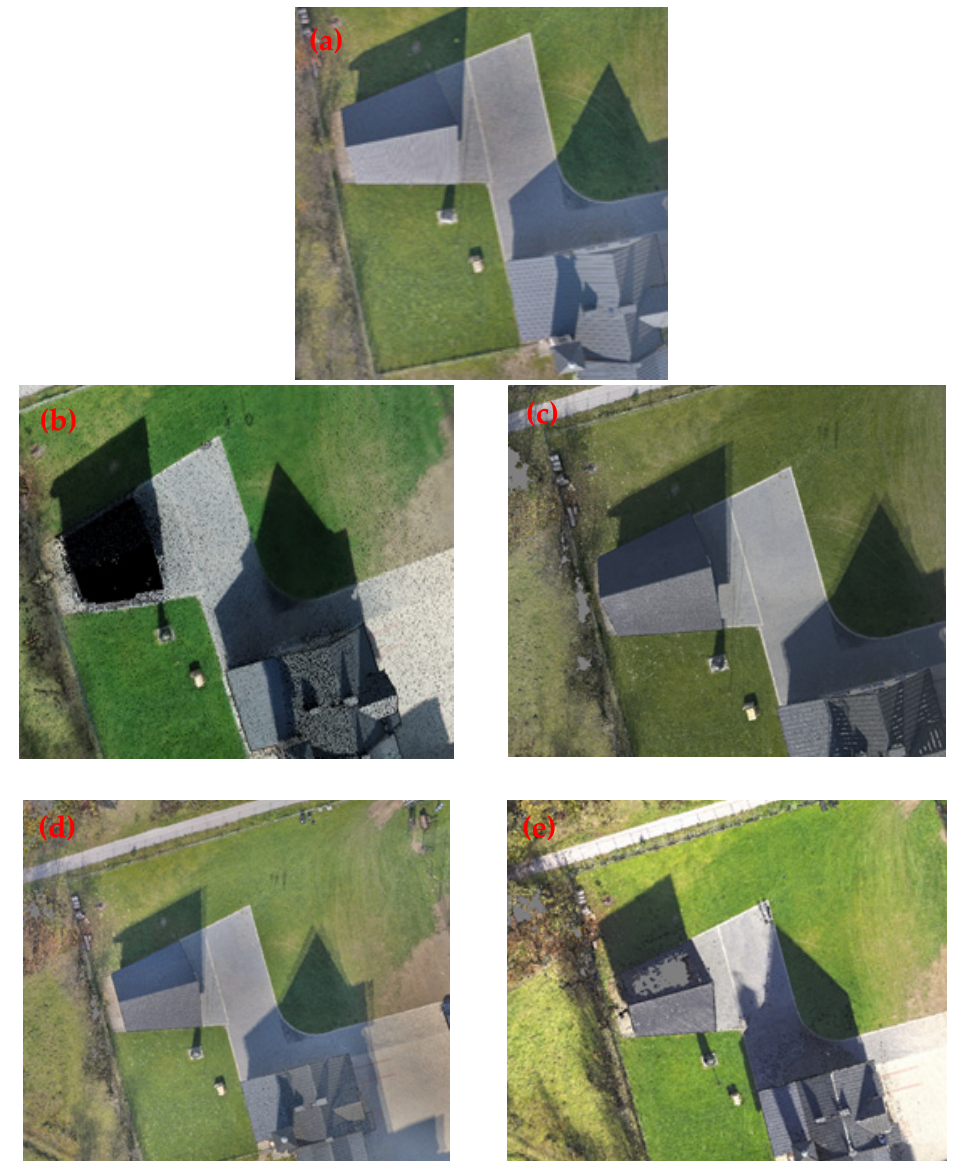
Figure 9. Lack of information for roof planes in point clouds example 3 ( a ) photos of roof planes ( b ) point cloud from L1 scanner, ( c ) point cloud from DNG files, P1 camera, ( d ) point cloud from TIF files, P1 camera, ( e ) point cloud from JPG files PSDK camera.